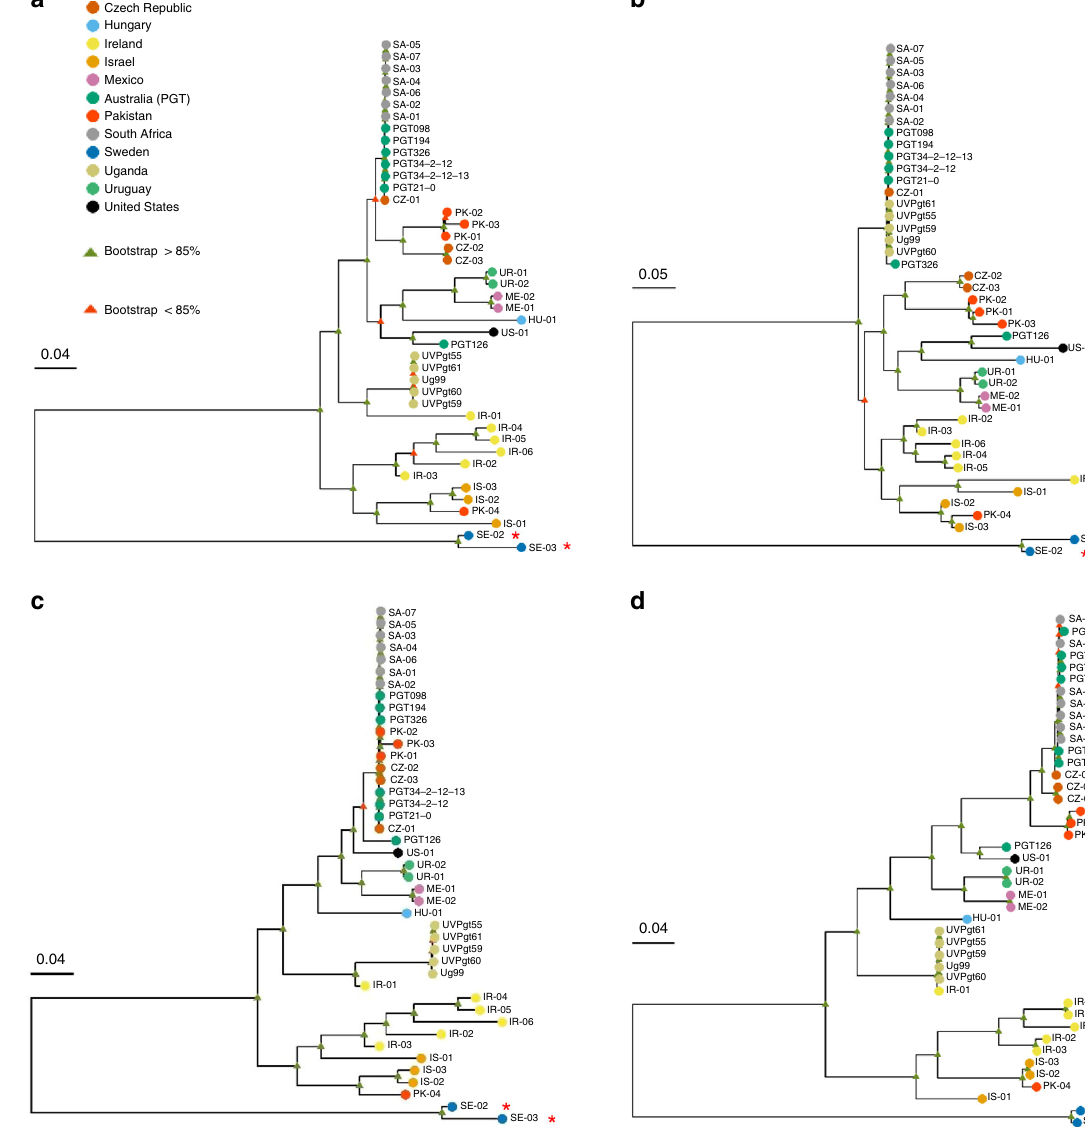
Fig. 9 Somatic hybridisation in Pgt evolution. a Phylogenetic analysis of Pgt isolates from diverse countries of origin (colour key) using a RAxML model and biallelic SNPs called against the full dikaryotic genome of Pgt 21-0. Scale bar indicates number of nucleotide substitutions per site. Red asterisks indicate P. graminis f. sp. avenae isolates used as an outgroup. b Dendrogram inferred using biallelic SNPs detected against haplotype A of Pgt 21-0. c Dendrogram inferred using SNPs detected against haplotype B of Pgt 21-0. d Dendrogram inferred from SNPs detected in haplotype C of TapeStation instruments (Agilent Technologies, Santa Clara, CA, USA). DNA 18°C for day/night, 50% relative humidity). Spores were collected 9 and 14 days was sheared to a targeted average size of 20 kb using G-tubes (Covaris, Woburn, post inoculation (dpi) and maintained at − 80 °C. DNA extraction and sequencing of rust isolates . High molecular weight DNA of Ug99 and Pgt 21-0 was extracted from 300 to 350 mg urediniospores as described 38 , with the following modi fi cations: (1) for Phenol:Chloroform:Isoamyl alcohol extractions, samples were centrifuged at 4 °C and 5000 × g for 20 mins; (2) a wide-bore 1-mL pipette tip was used to transfer the DNA pellet; (3) samples were incubated for 1 h at 28 °C with 200 – 250 rpm shaking to dissolve the fi nal DNA pellet. Double-stranded DNA concentration was quanti fi ed using a broad- range assay in a Qubit Fluorometer (Invitrogen, Carlsbad, CA, USA) and a NanoDrop (Thermo Fisher Scienti fi c, Waltham, MA, USA). Approximately 10 µg DNA from Ug99 and Pgt 21-0 was sequenced using PacBio SMRT sequencing (Paci fi c Bioscience, Menlo Park, CA, USA) at either the Frederick National Laboratory for Cancer Research, Leidos Biomedical Research, Inc. (Frederick, MD, USA) or the Ramaciotti Centre (Sydney, Australia), respectively. DNA was concentrated and cleaned using AMPure PB beads for Ug99 or AMPure XP beads for Pgt 21-0 (Paci fi c Biosciences). DNA quanti fi cation and size assessment were conducted using a NanoDrop (Thermo Fisher Scienti fi c) and 2200